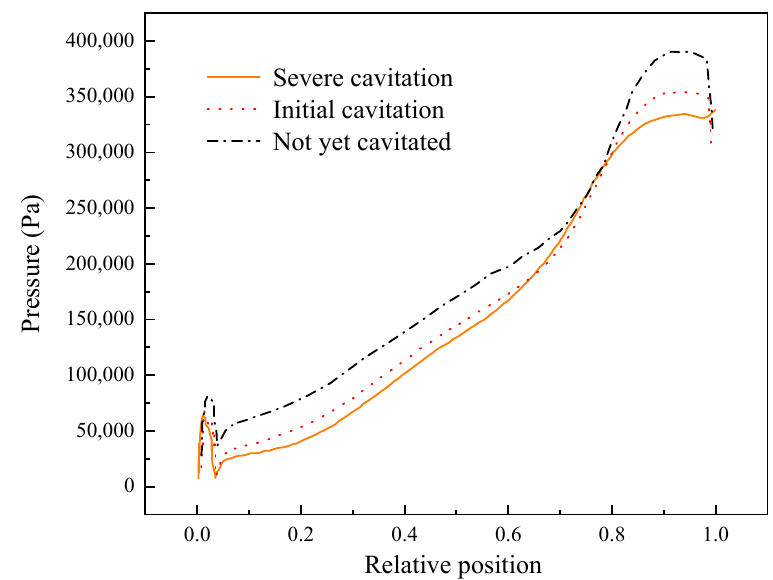
Figure 11. Blade’s surface pressure–load distribution curve.